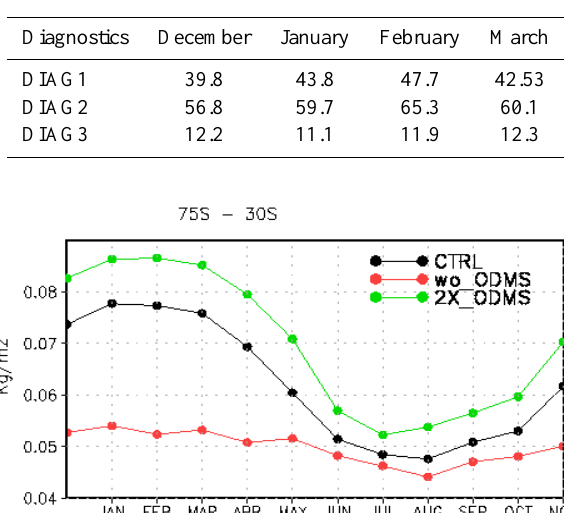
Table 4. Percentage mean change in DIAG1, DIAG2, DIAG3 for the zonally and vertically averaged cloud liquid water over 30S-75S latitudinal belt.